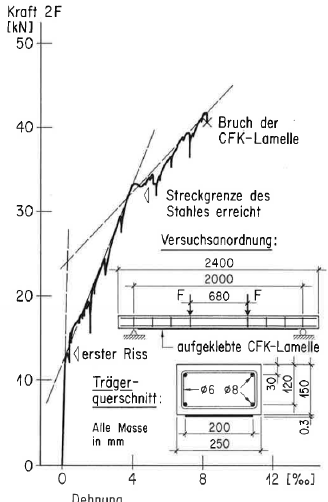
Figure 4. Typical load-displacement diagram of a CFRP strengthened RC beam, showing first cracking and yielding of the internal steel, published in German and French in the year 1987 [15]. Source Empa.